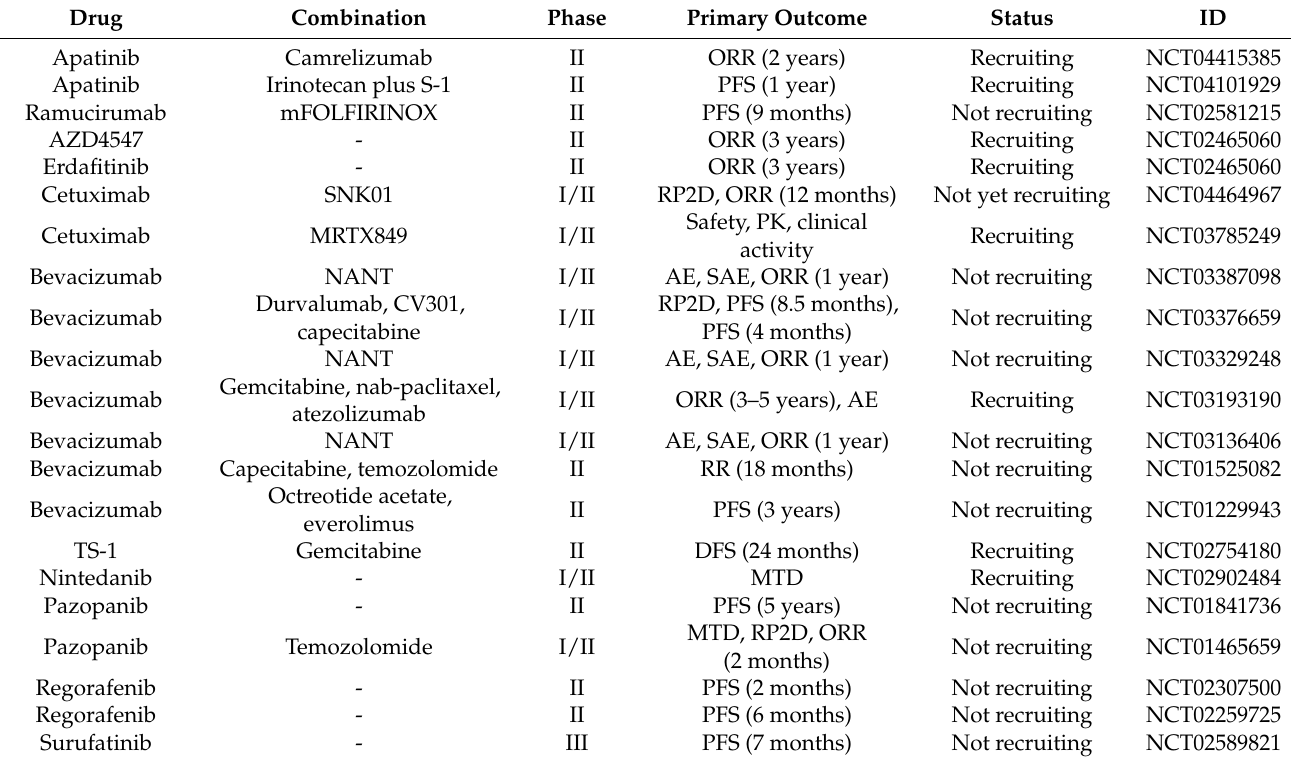
Table 4. Anti-angiogenic drugs in ongoing clinical trials for the treatment of pancreatic cancer and their respective targets.